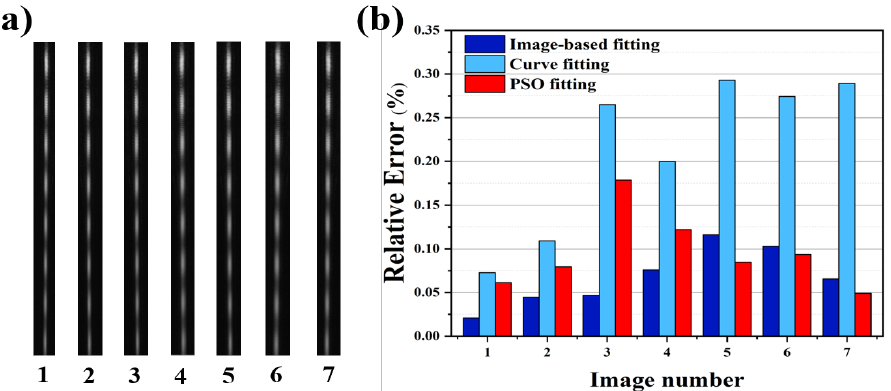
Figure 4. Measured results for the filament diameter of 125.2 ± 0.1 µ m: ( a ) diffraction images of a 125.2 µ m diameter filament at a focal length ( f ) of 120 mm; ( b ) measured results of 125.2 µ m filaments with different